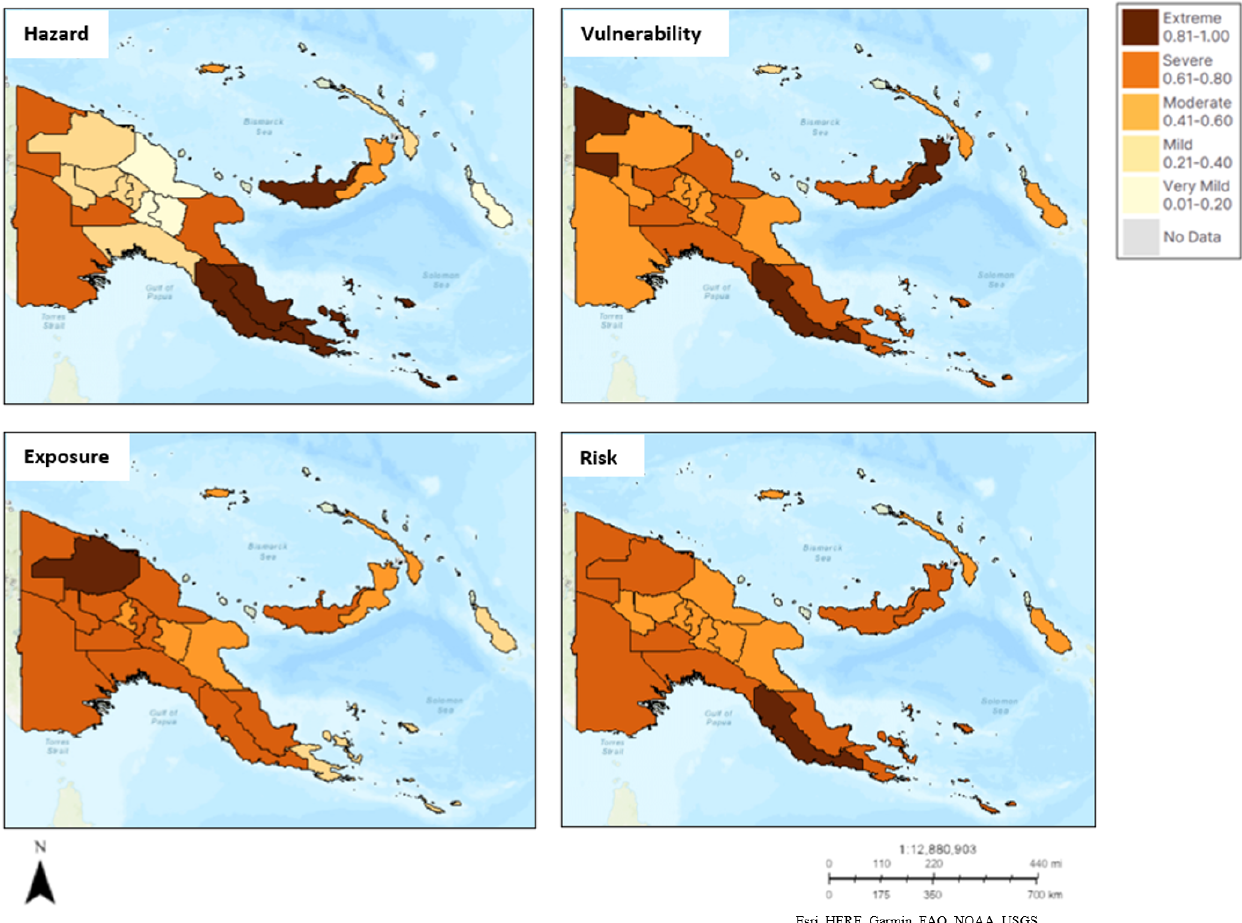
Figure 7. Overall drought risk maps of PNG provinces for 2016 including a drought hazard, drought vulnerability, drought exposure, and drought risk map detailing the index level of each province. The index level is classified on a deepening orange colour scale from very mild (index values from 0.01–0.20) to extreme (index values from